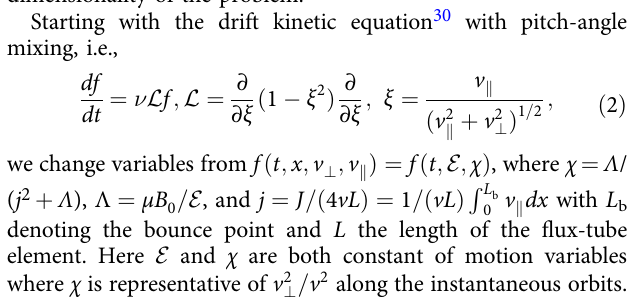
denoting the bounce point and L the length of the fl ux-tube element. Here E and χ are both constant of motion variables = v 2 along the instantaneous orbits. where χ is representative of v 2 ?